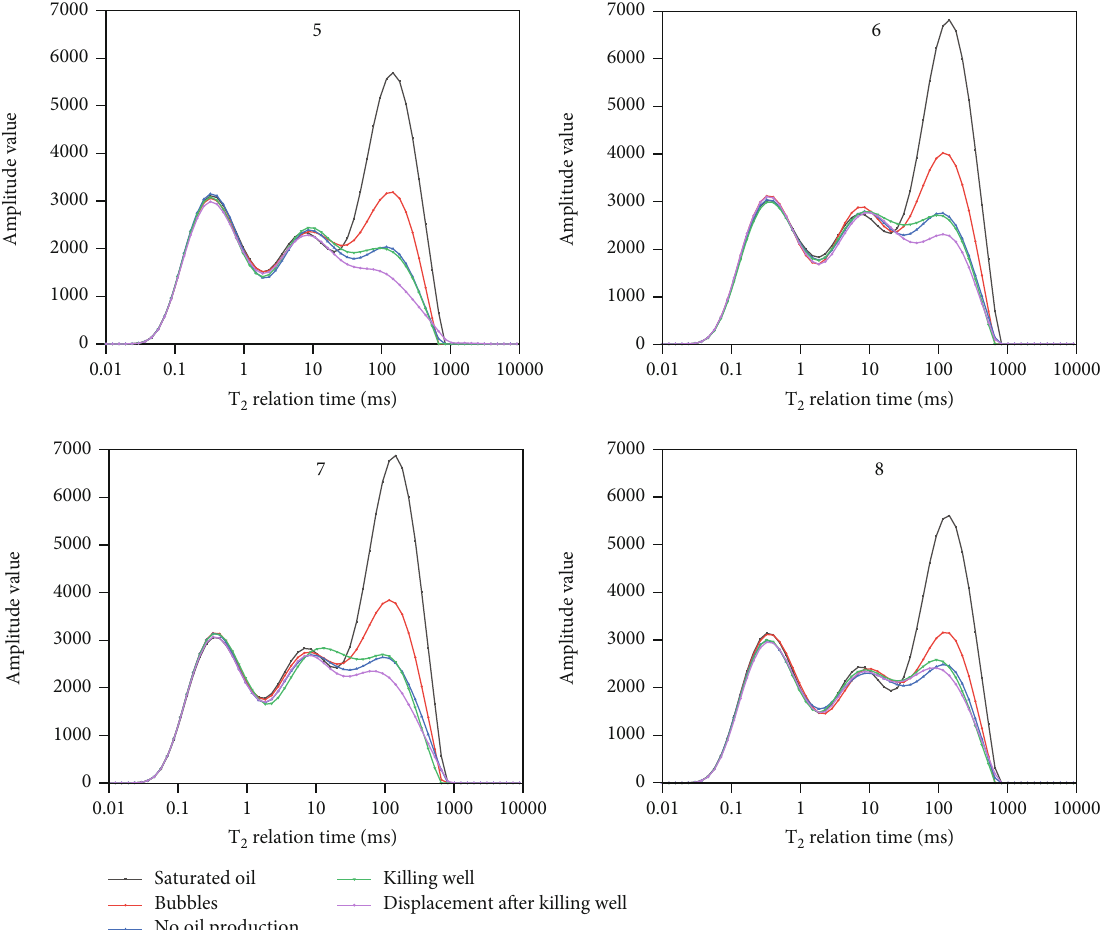
ff erent displacement